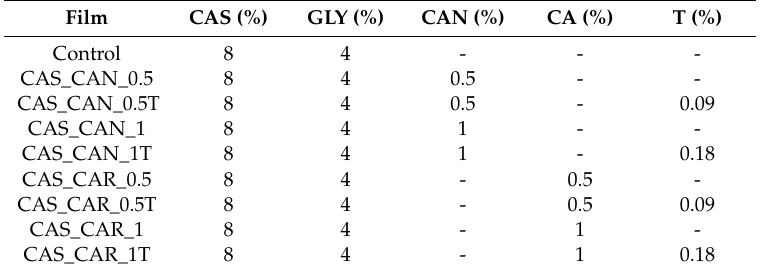
Table 1. Composition of sodium caseinate films with candelilla and carnauba wax.